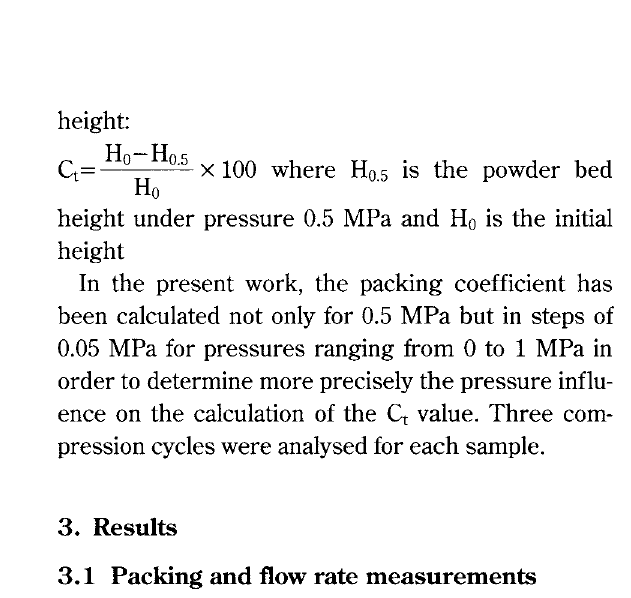
Flow-function and classification according to the flowabil ity index (i) [5] filled with an accurate mass of product, calculated from the bulk density of the materiaL Compression was performed by the displacement of the upper punch at a speed set at 1.14 mm/min. The pressure was measured by an accurate gauge and the upper punch displacement was measured with an external LVDT extensometer. Compression data (displace ment as a function of pressure) were collected until the predefined pressure was reached. Only the begin ning of the curve will be discussed here (0 to 1 MPa).